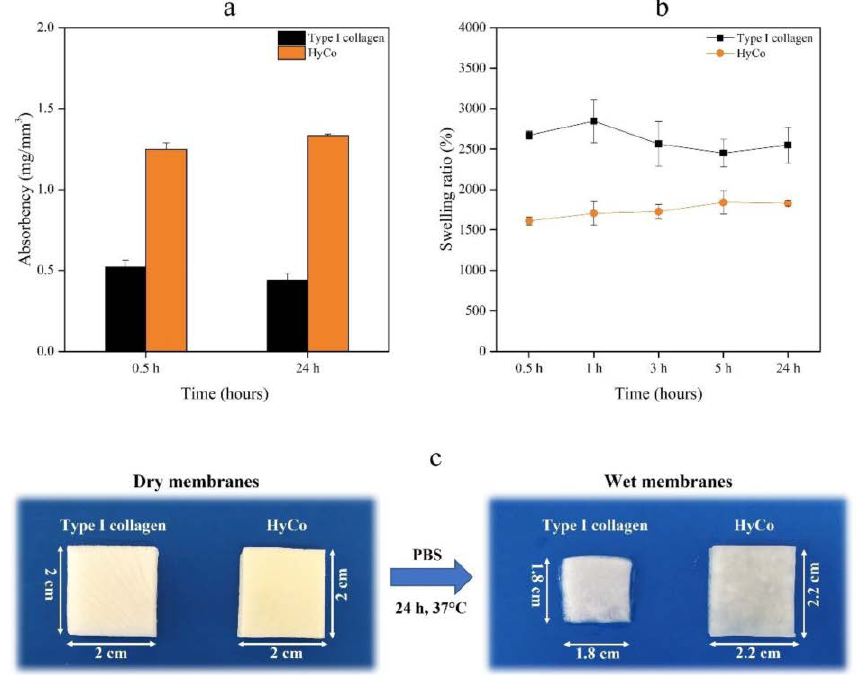
Figure 5. Absorbency and swelling ratio assays on commercial collagen scaffold and HyCo. Absorp- tion capability of a saline solution (142 mM NaCl, 2.5 mM CaCl 2 ) by collagen and HyCo scaffold at 30 min and 24 h expressed as mg/mm 3 ( a ), and related swelling ratio (%) at different time points ( b ). Data are presented as mean ± standard error. Pictures are of dry samples and samples after 24 h of incubation with PBS at 37 ◦ C ( c